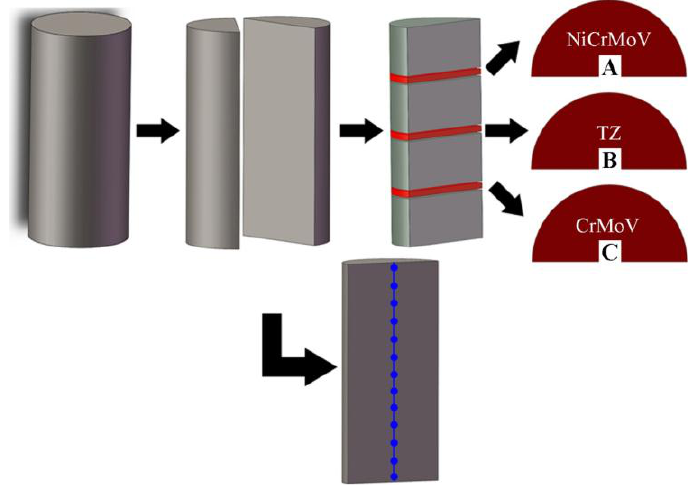
Figure 1. Schematic drawing of the dissection of the electroslag remelting (ESR) ingot.